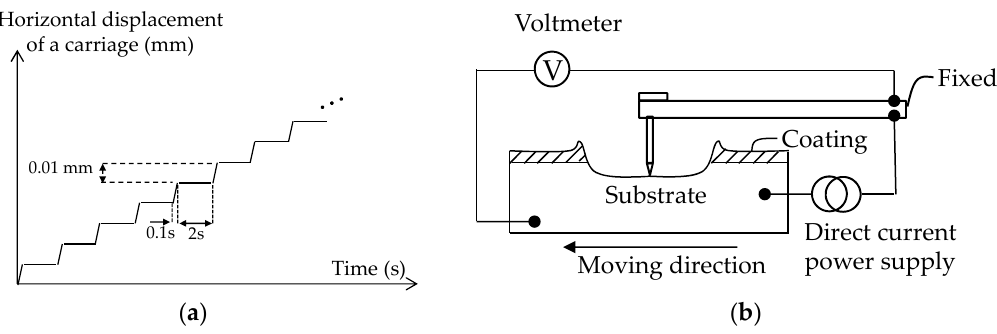
Figure 2. Induced displacement and measurement of electrical contact resistance: ( a ) induced horizontal displacement over time; ( b ) four-wire resistance method.